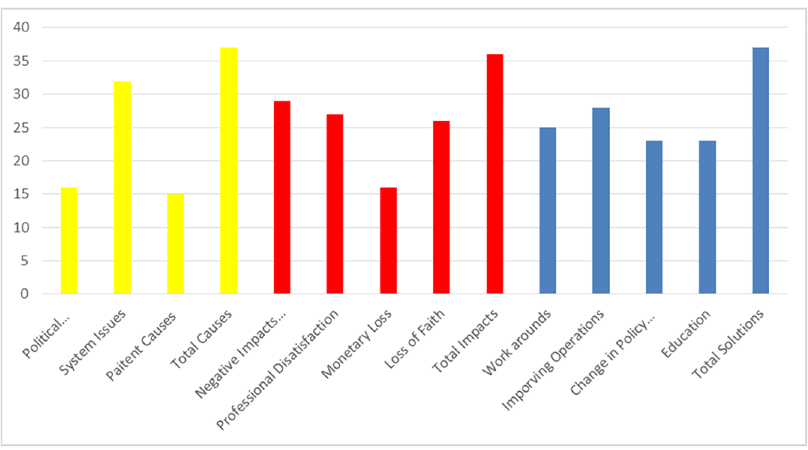
Fig 2. A summaryof topics discussed by 48 participants in 37 interviews. The yellow bars indicate the causes, red the impacts and blue the solutions.